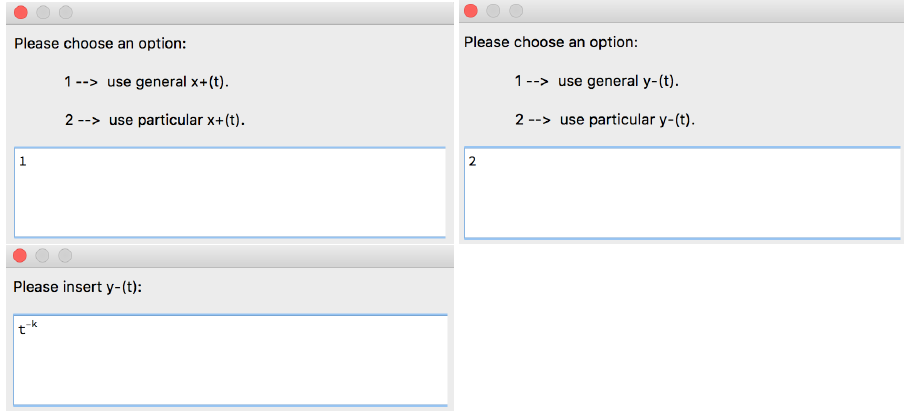
Figure 2. Part of the structure of the [SInt] algorithm corresponding to the Input of x + and y − . The [SInt] algorithm gives the singular integrals presented in Figure 3.